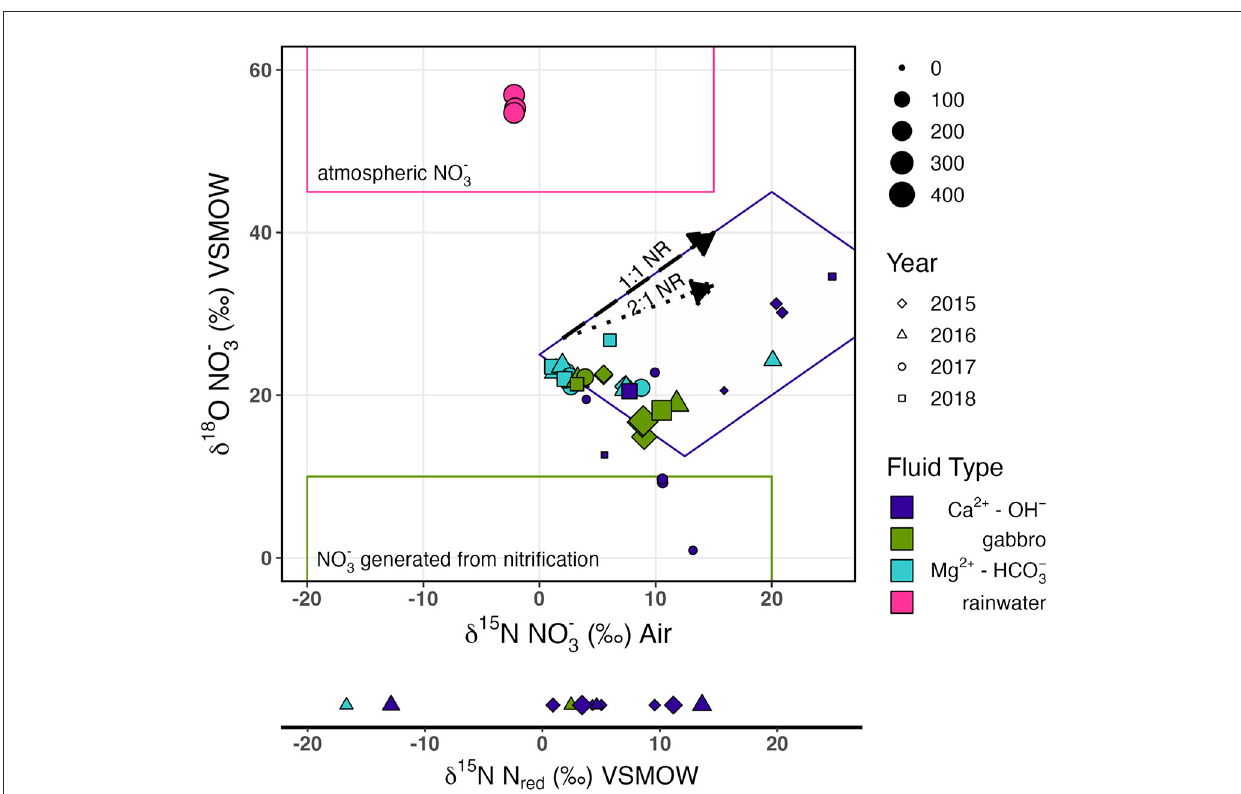
FIGURE3 δ 15 N of reduced N plotted on the same scale. Colors indicate fluid type, shapes indicate the year of sampling, δ 18 O vs. δ 15 N of NO − 3 biplot, with the and the size of points represents the concentration of N species in µ M. Trends for NR with a slope of 1 (labeled 1:1; long dash) and 0.5 (labeled 2:1 with dotted arrow) are illustrated. The field outlined in pink represents the common isotopic composition for atmospheric NO − 3 , the field outlined in green represents the common isotopic composition of nitrified NO − 3 , and the field outlined in purple represents samples with 15 N- and 18 O-enriched isotopic compositions consistent with NR. Isotopic fields for common isotopic compositions were sourced from Kendall et al. (2007).